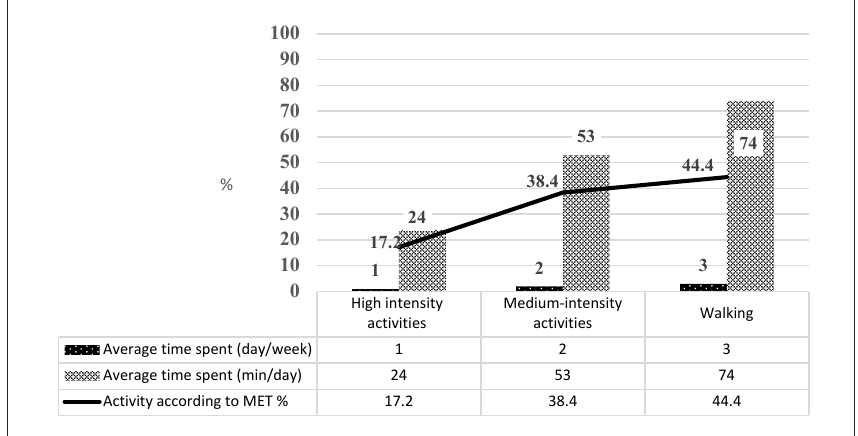
Figure 2. Distribution of respondents according to the average physical activity intensity indicators in the group of medium FA level